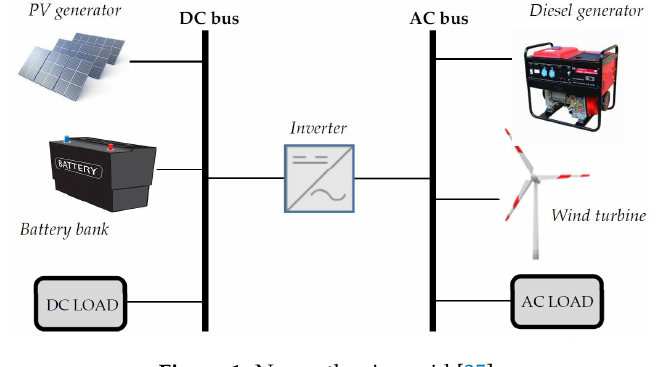
Figure 1. Nazareth microgrid [35].